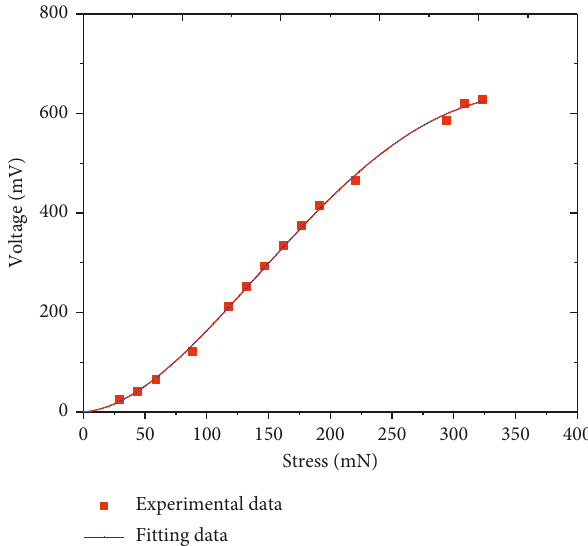
Figure 3: Static response of magnetostrictive whisker sensor with stress from 0.029 to 0.323N.